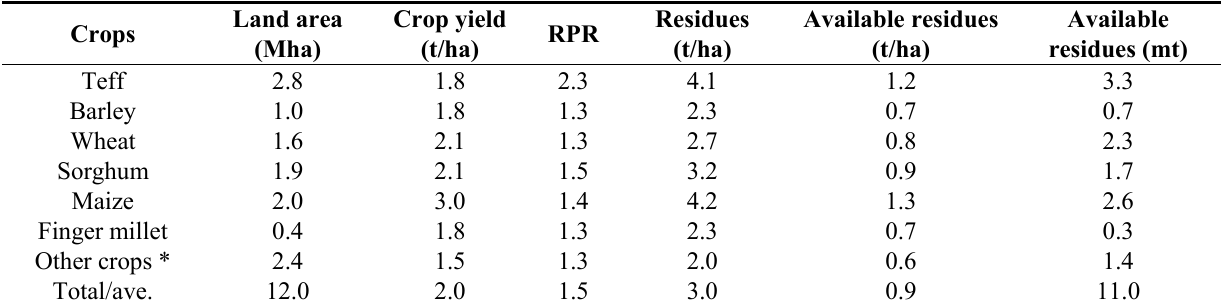
Table 2. Estimated available crops residues for energy based on